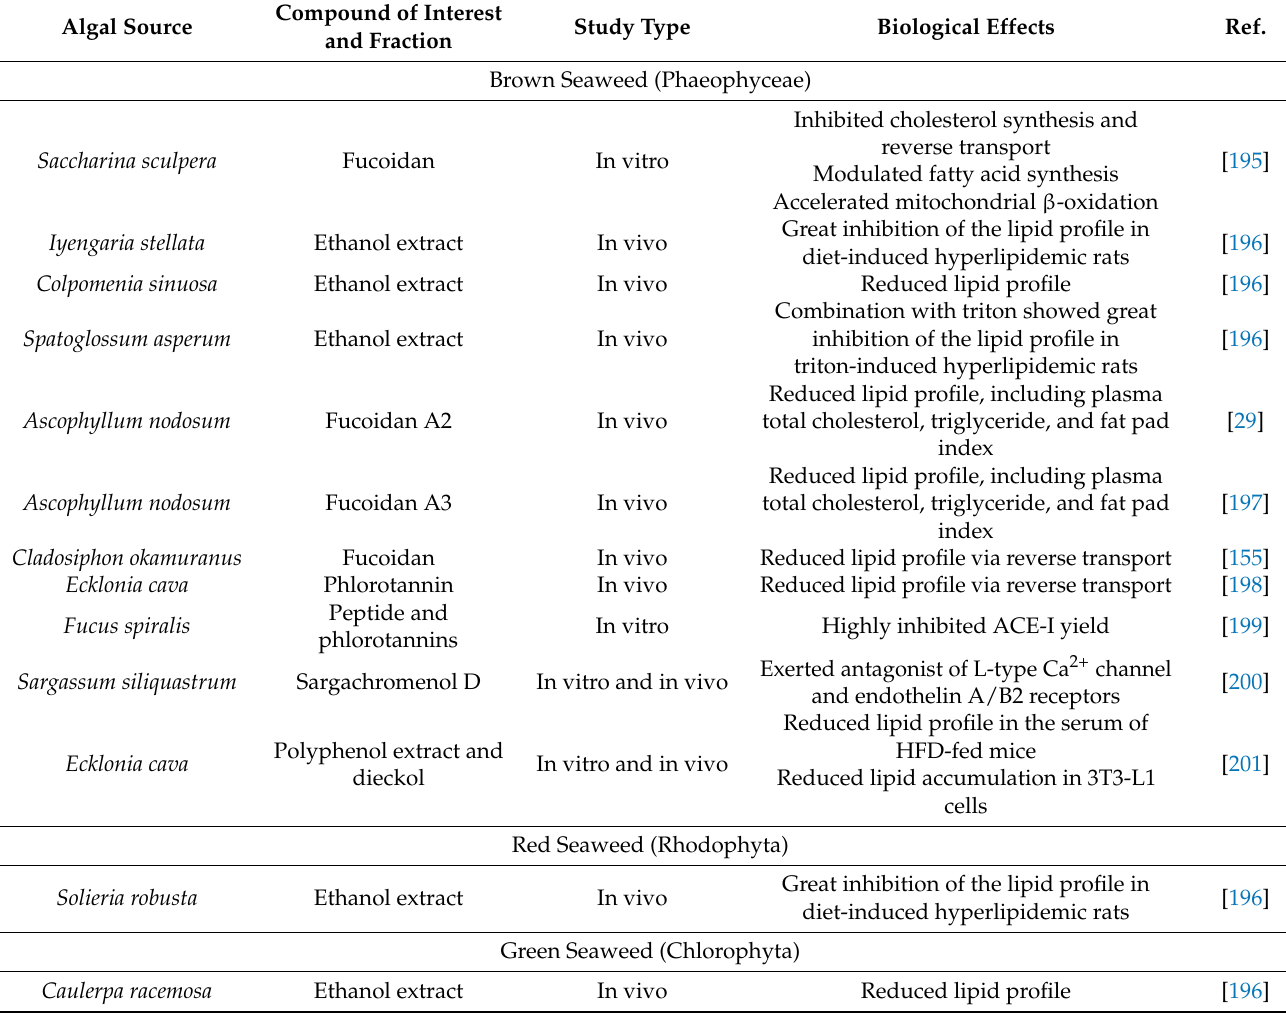
Table 6. The effects of seaweed-derived compounds on cardiovascular